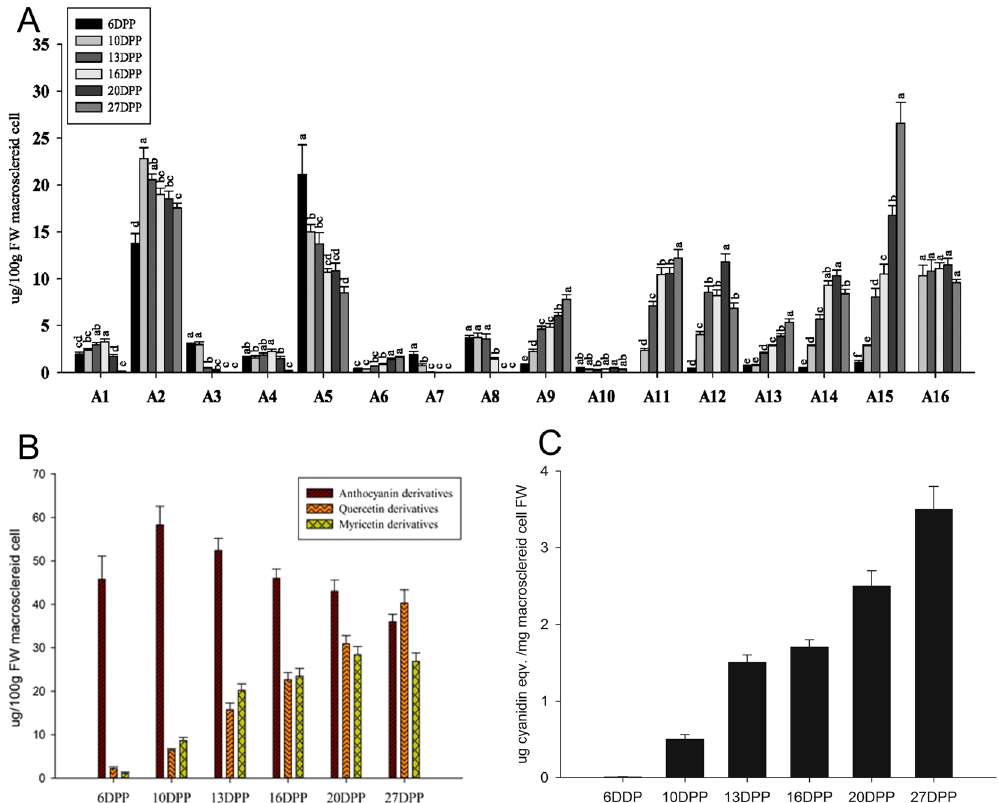
Figure 3. Flavonoid profiles at six different time points during M . truncatula MC development. ( A ) Sixteen flavonoids were identified by HPLC-MS using Fisher’s Least Significant Difference test (p < 0.05, LSD). The identified compounds from each profile are listed in Table 1. The HPLC conditions are described in Materials and Methods. Values represent the average ± SD of nine biological replicates. ( B ) The concentration of three types of flavonoid derivatives present in MC. Values represent the average ± SD of nine biological replicates. ( C ) In-PA content in MC using BuOH-HCl assays. Values represent the average ± SD of three biological